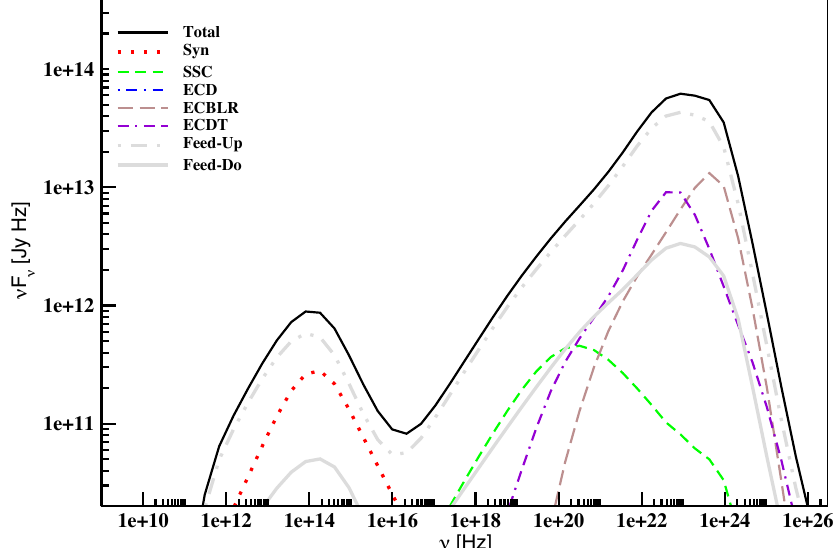
Figure 3. Time-averaged spectral energy distributions (SEDs) of the generic blazar for our base set obtained using a tangled magnetic field. The thick black solid line shows the total SED that is averaged over a flaring period of ∼ 1 day. The contribution of various radiative components is indicated by lines shown as dotted: synchrotron; small-dashed: SSC; dot-dashed: ECD (cannot be seen here as its flux level is below 10 10 Jy Hz for this case); long-dashed: ECBLR; dot-double-dashed: ECDT; dash-double-dotted: Feed-Up; thick solid grey: